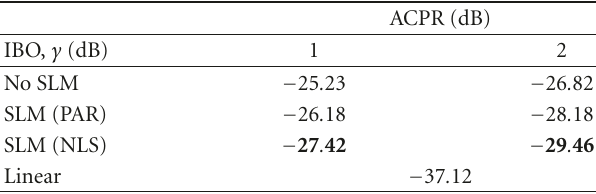
Table 3: ACPR for 16-OFDM in Presence of